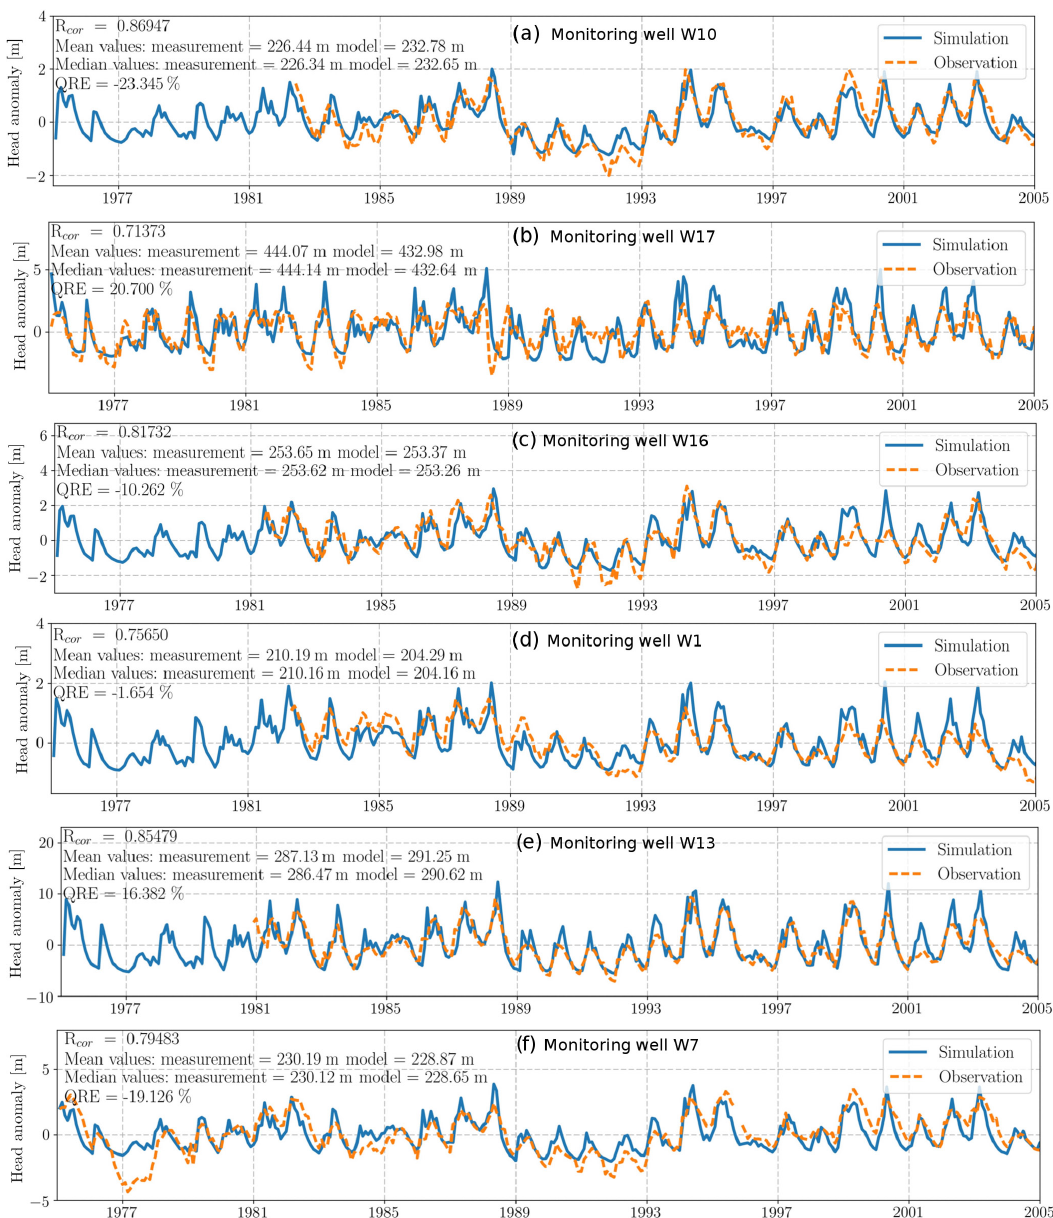
Figure 10. Comparison between measured (green dashed line) and simulated groundwater head anomalies (blue solid line). (a) W10 is located in the uplands, near a stream. (b) W17 is located in a mountainous area. (c) W16 is located at a hillslope in the northern uplands. (d) W1 is located in the lowlands. (e) W13 is located in the northern mountains. (f) W7 is located in the northern uplands.